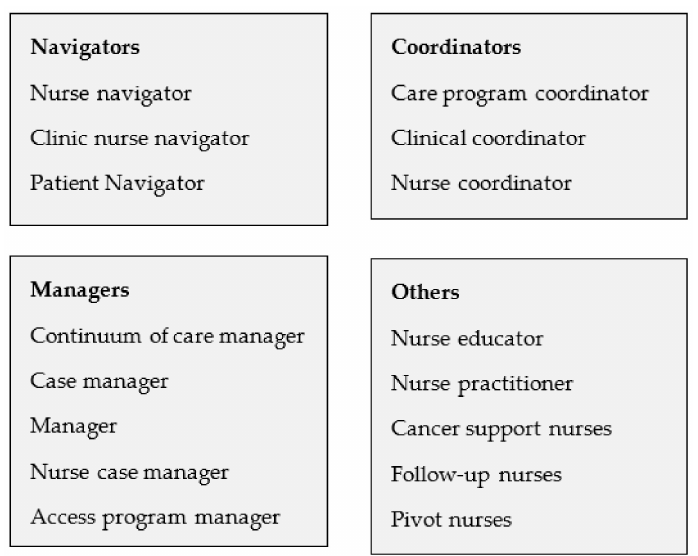
Figure 1. Diversity in nurse coordinator titles